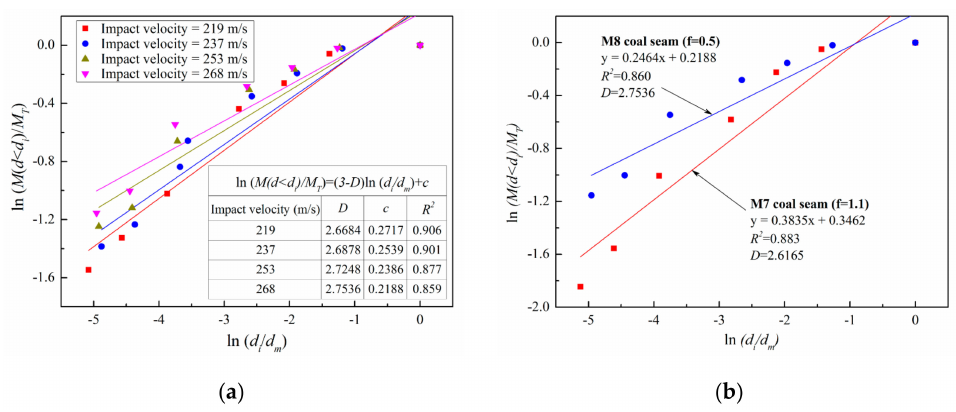
Figure 12. Diagrams of the relative mass versus the relative fragment size for coal fragments generated from WJD holes in coal seams: ( a ) M8 coal seam and ( b ) M7 and M8 coal seams for an impact velocity of 268 m/s.